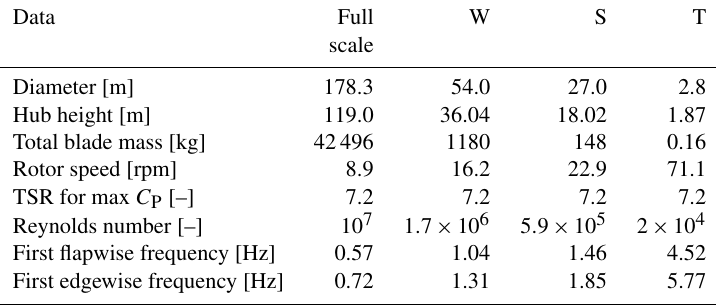
Table 7. Gravo-aeroservoelastic scaling requirements for the W, S, and T models.